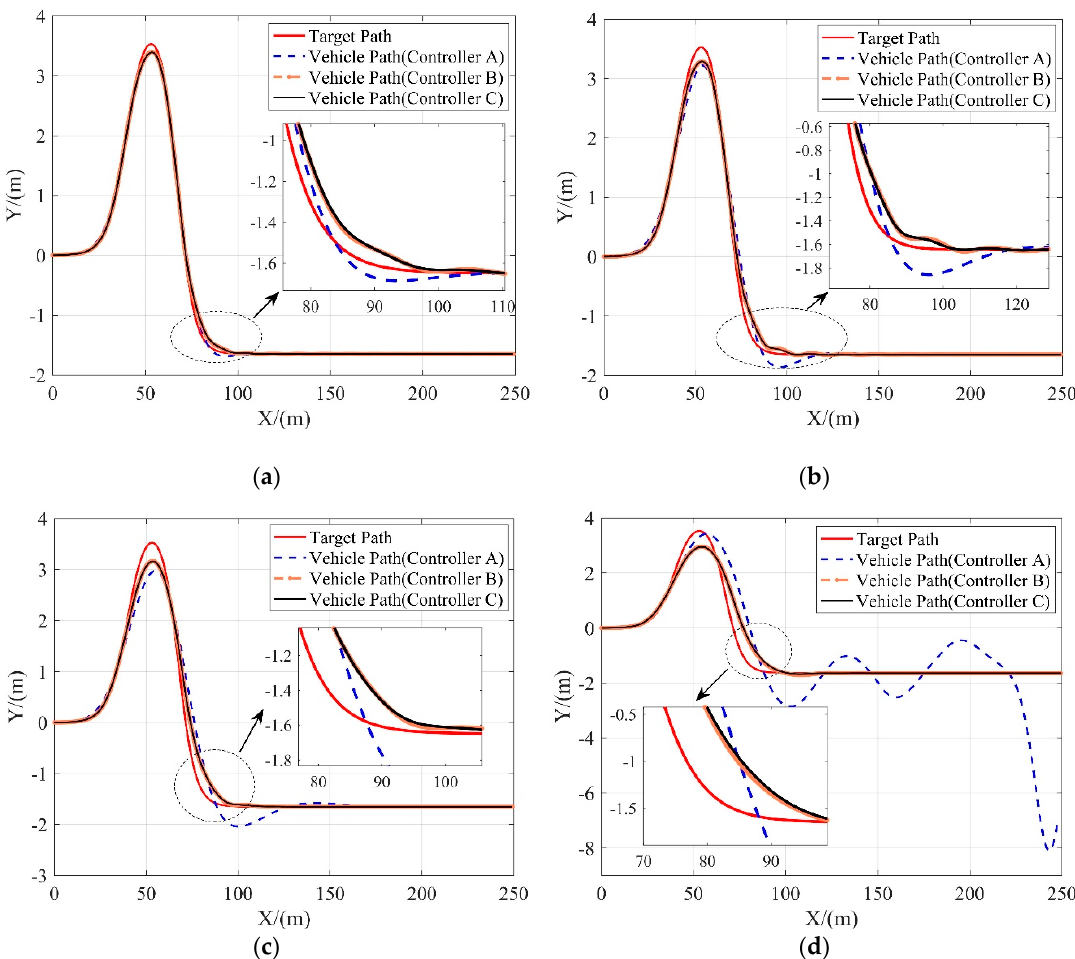
Figure 7. Tracking performance of 3 controllers in terms of the lateral position at different vehicle velocities. ( a ) 10 m/s; ( b ) 15 m/s; ( c ) 20 m/s; ( d ) 25 m/s.